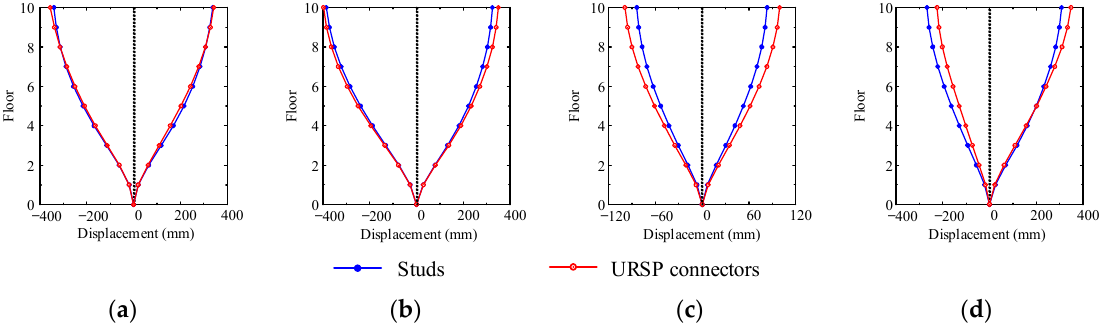
Figure 9. Lateral displacement when the maximum roof displacement occurred: ( a ) case XL1; ( b ) case YL1; ( c ) case YS1; ( d ) case XL2.